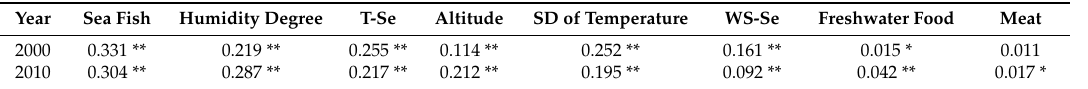
Table 3. Linear regression coefficient of each factor with longevity in regression